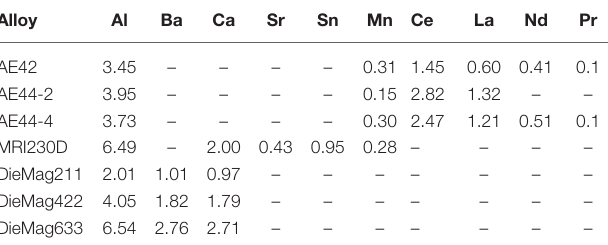
TABLE 1 | Chemical compositions (wt.%) of die-cast alloys in this investigation analyzed by ICP-OES or Arc Sparc OES (Dieringa et al., 2013; Zhu et al., 2015).